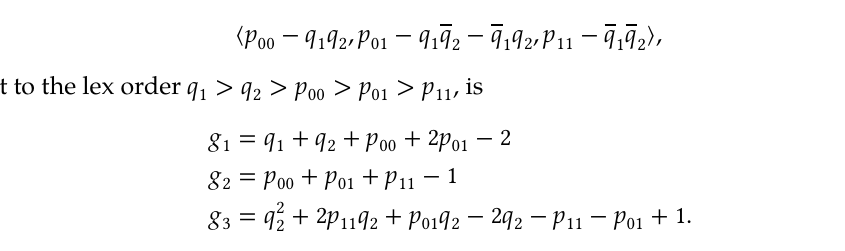
+ 2 u  2 ≥ 4 u 01 00 00